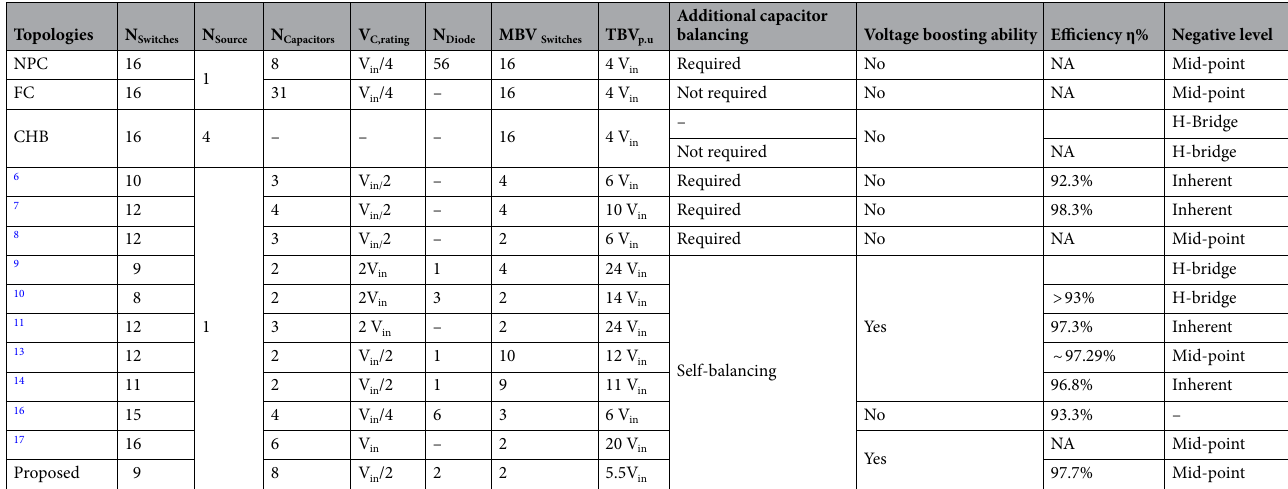
Table 3. Comparison of proposed 9L-inverter with conventional and other recent SCMLI topologies. TBV total blocking voltage of switches, MBV switches number of switches with maximum blocking voltage, NA not